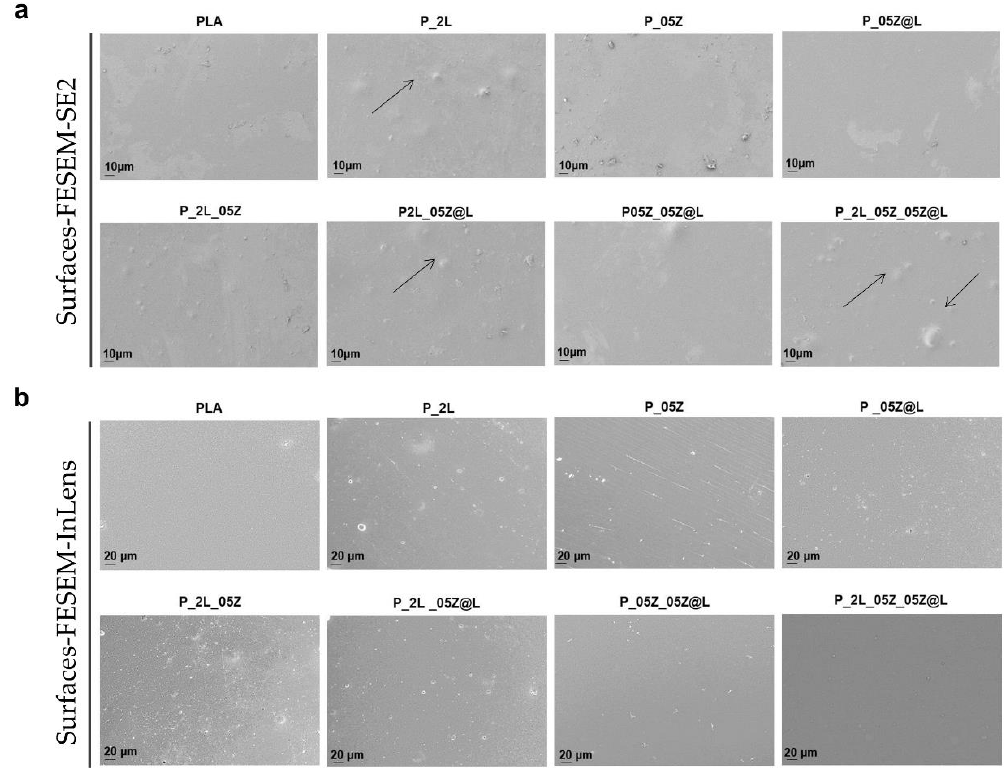
Figure 3. Microstructure surface investigation of PLA systems by using ( a ) FESEM and SE2 detector and ( b ) FESEM and InLens detector (arrows indicates the presence of nanoparticles on surface of the films).